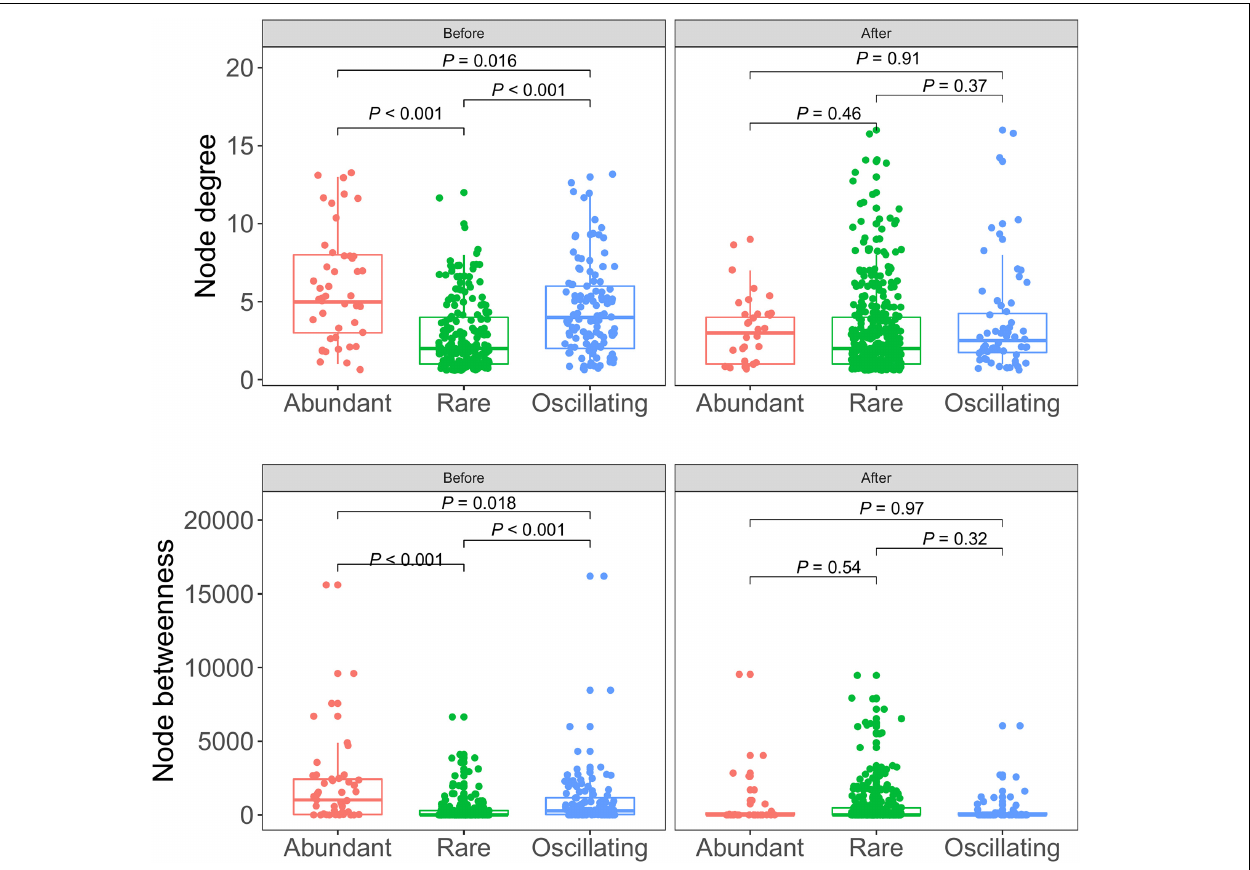
FIGURE 6 | Node-level topological features between abundant, rare, and oscillating taxa in cryoconite communities before and after snowfall disturb. Each dot represents an individual sample. In the community before snowfall, the node degree and betweenness of the abundant bacterial were significantly higher than that of rare bacterial and oscillating taxa (Wilcoxon rank-sum test, P < 0.05).